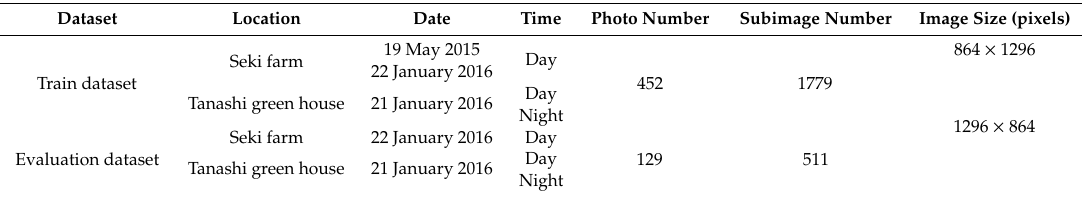
Table 2. Details of the training and evaluation datasets.